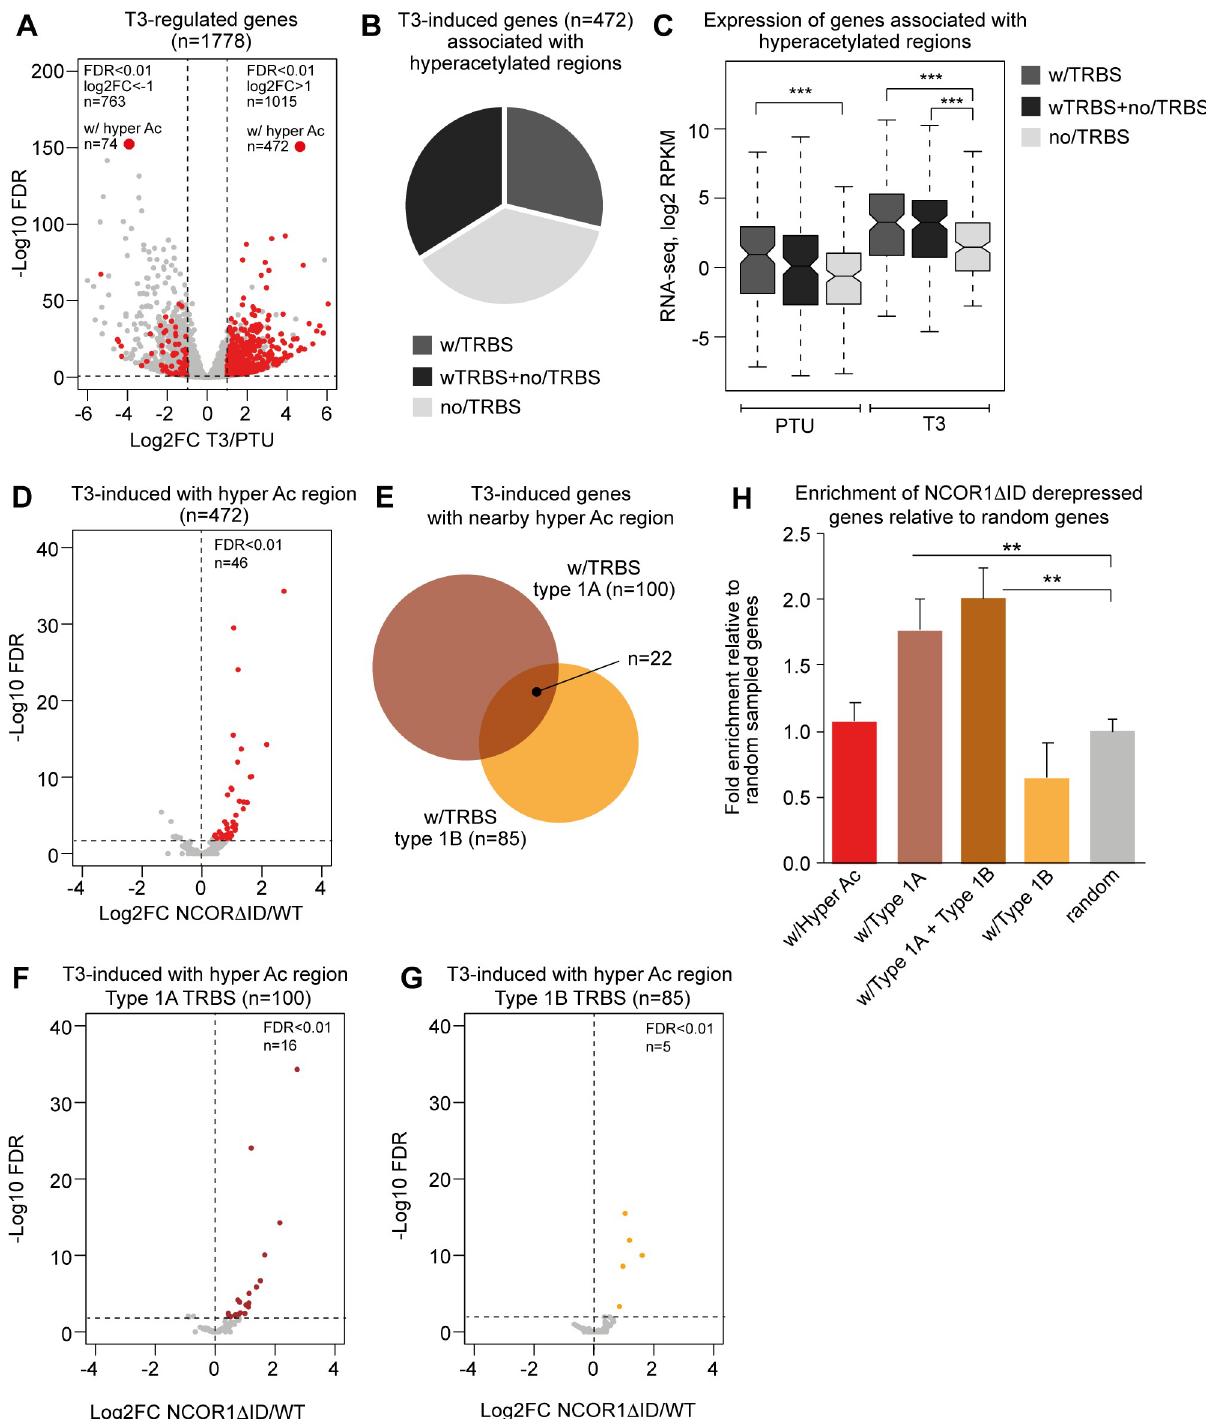
Fig 5. Expression of genes associated with hyperacetylated regions with and without occupancy of HDAC3. (A) Differentially expressed genes in hyperthyroid condition. Genes associated with hyperacetylated regions are marked by red. Genes are scored positive if one or more hyperacetylated regions are within 100kb of the transcriptional start site of the gene. The number of induced and repressed genes at FDR < 0.01 and log2FC of one are indicated. (B) Fraction of T3-induced genes with nearby hyperacetylated regions with and without TRBSs. (C) Expression of genes associated with hyperacetylated regions as sequenced reads per kilo base per million total reads (RPKM). Statistical difference was determined by a Wilcoxon Signed Rank Test, ��� p < 0.001. (D) Differential expression of T3-induced genes associated with hyperacetylated regions in hypothyroid WT mice compared to